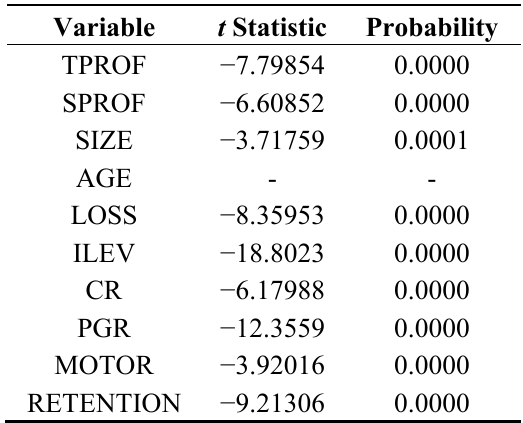
Table 4. Panel Unit Root Test Results.